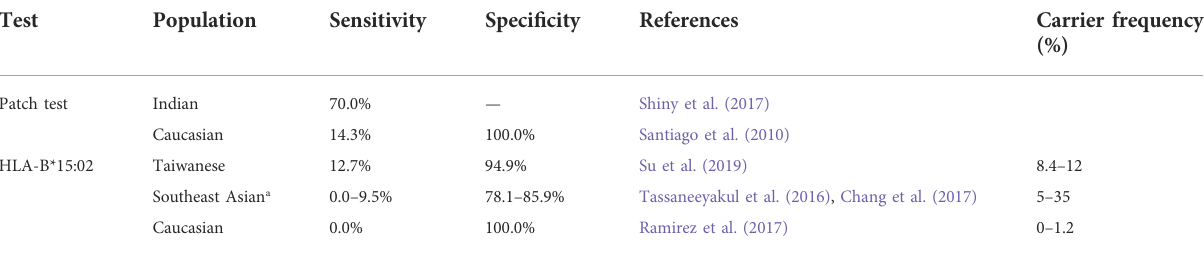
TABLE 6 Sensitivity and speci fi city of patch tests and HLA tests for phenytoin-induced DRESS.